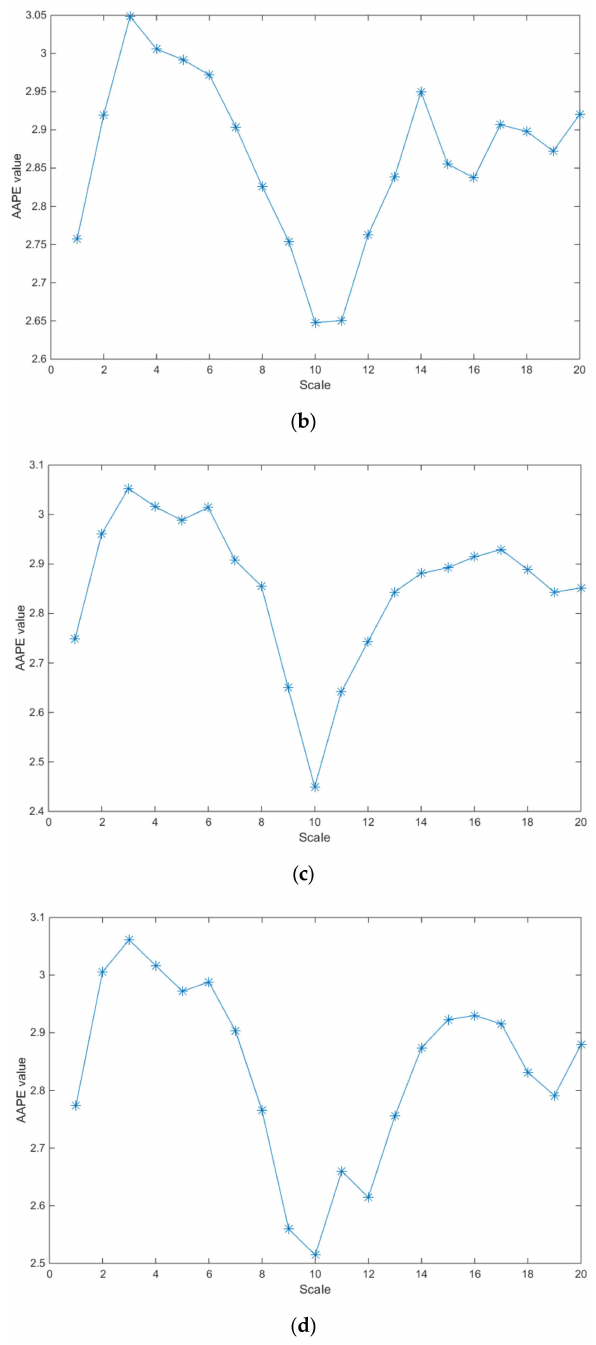
Figure 5. MAAPE feature values of rolling bearing vibration signal under inner race fault condition with di ff erent loads. ( a ) Inner race fault, 7 mils, with load 0 hp. ( b ) Inner race fault, 7 mils, with load 1 hp. ( c ) Inner race fault, 7 mils, with load 2 hp. ( d ) Inner race fault, 7 mils, with load 3